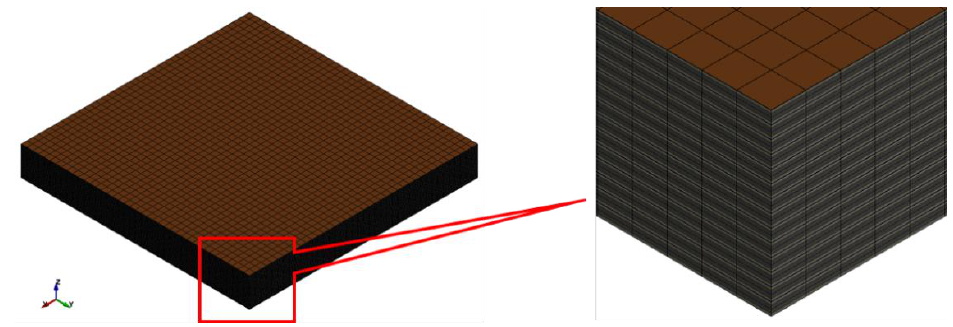
Figure 5 . A battery cell model with a heterogeneous modelling technique . Figure 5. A battery cell model with a heterogeneous modelling